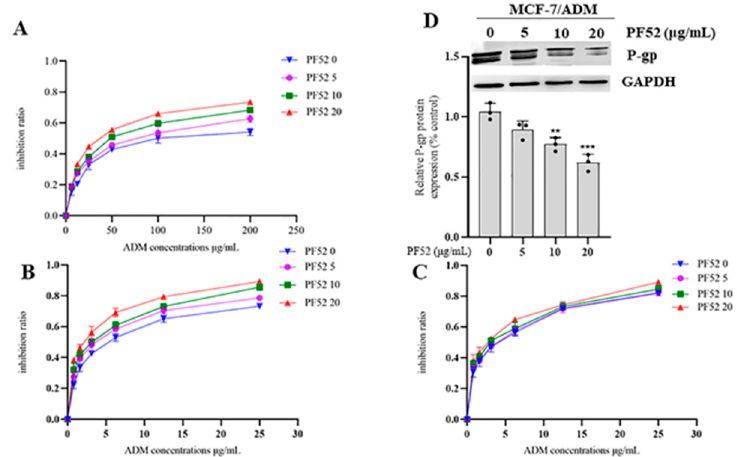
Figure 7. Inhibition ratios of ADM at different concentrations combined with compound 2 (PF52) at concentrations of 0, 5, 10 and 20 µ g/mL, respectively: ( A ) MCF-7/ADM; ( B ) K562/ADM; ( C ) A549/ADM; ( D ) Effect of 2 (PF 52) on P-gp expression. All experiments were performed in triplicate. ** p < 0.01, and *** p < 0.001.